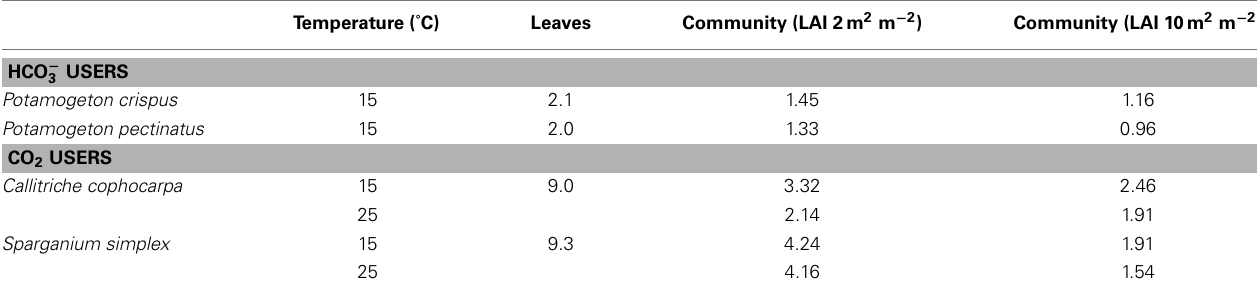
Table 2 | Increase (x-fold) of maximum gross production of O 2 at high (250 µ mol L − 1 ) relative to low (20 µ mol L − 1 ) CO 2 concentration in alkaline